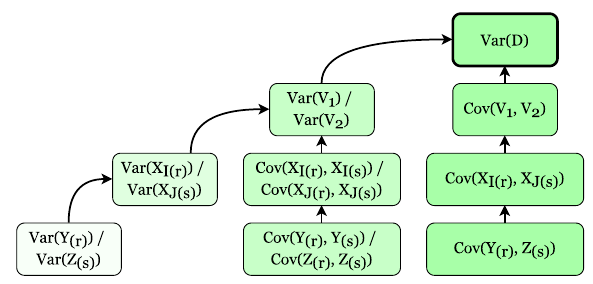
Fig. 3 Relationship between different variances/covariances used to calculate the variance of D , the value gained when the estimation noise is reduced. An arrow from quantity A to B means the value of B is dependent on the value of